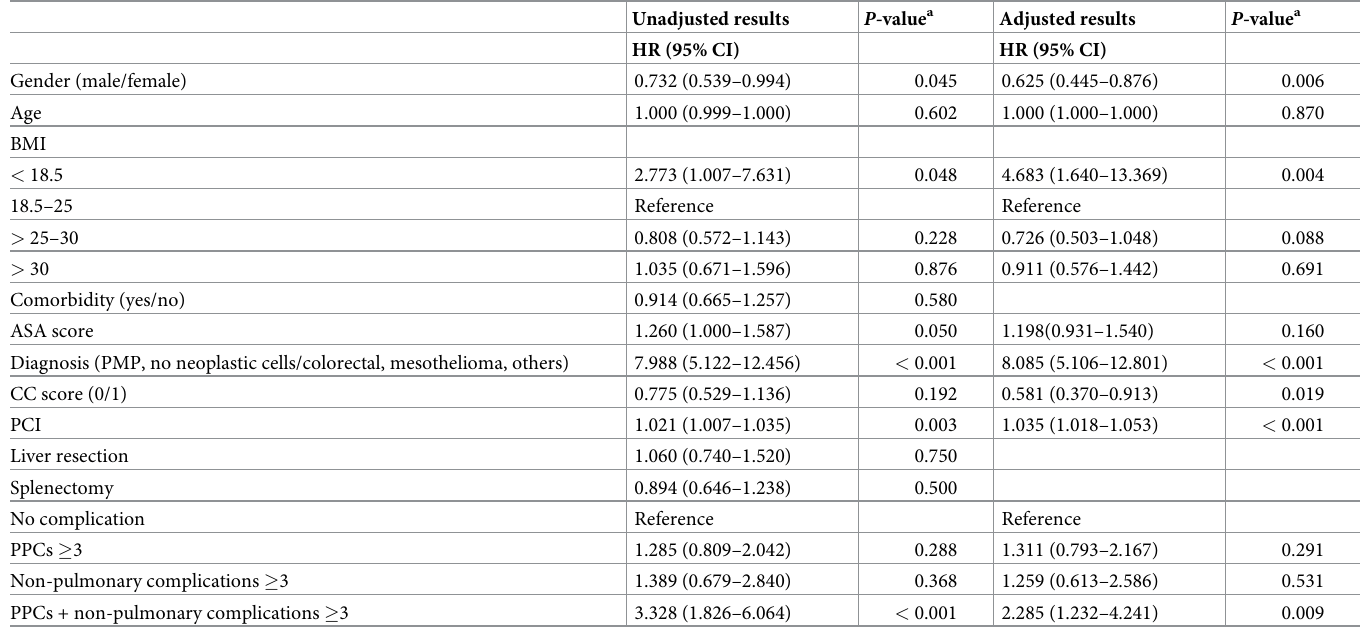
Table 3. Unadjusted and adjusted results of hazard ratios and p-values for the variables included in the final model on overall survival after CRS and